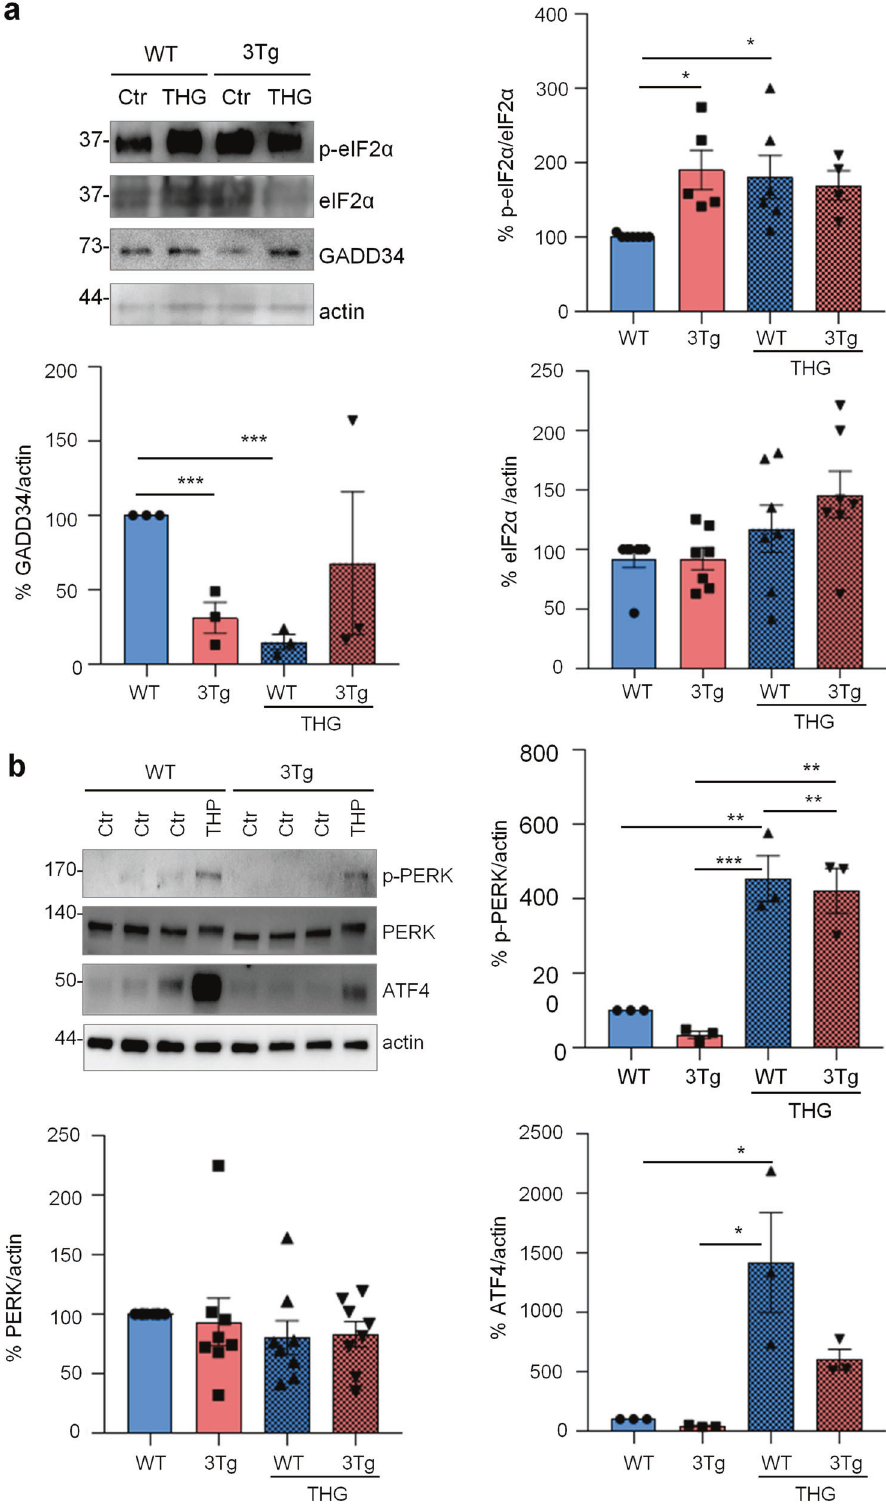
Fig. 2 PERK-independent activation of p-eIF2 α . a Analysis of eIF2 α phosphorylation and GADD34 expression on WT and 3Tg-iAstro. Cells were treated or not with 1 µM THG for 1 h, lysed and analysed by WB with anti- p-eIF2 α , eIF2 α , GADD34 and actin antibodies. Data are expressed as mean ± SEM of n = 4 (3Tg-iAstro + THG), n = 5 (3Tg-iAstro) or n = 6 (WT- and WT-iAstro + THG) independent experiments; * p < 0.05 by one-way ANOVA, Sidak ’ s multiple comparison; *** p < 0.001 Dunnet ’ s multiple comparisons. b Analysis of PERK phosphorylation and ATF4 induction on WT- and 3Tg-iAstro cells. WB analysis of cells treated as in a with anti-p-PERK, PERK, ATF4 and actin antibodies. Data are expressed as mean ± SEM from n = 3 (p-PERK and ATF) or n = 8 (PERK) independent experiments. * p < 0.05, ** p < 0.01 and *** p < 0.001 by one- way ANOVA, Sidak ’ s multiple